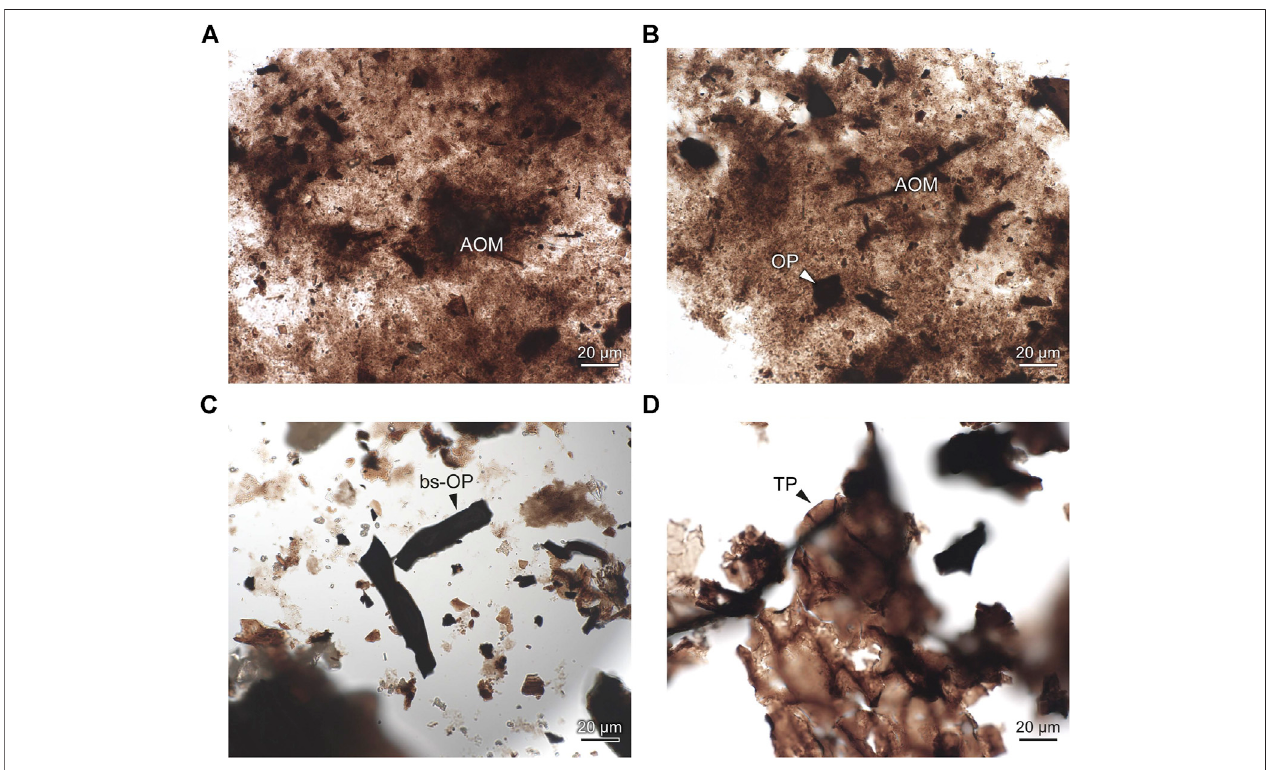
FIGURE7| PalynofaciesmicrophotographsfromtheCHE-1core. (A) amorphousorganicmatter(AOM – probablyalgal-bacterial-derived),245.6 m; (B) AOMand opaque phytoclasts (OP), 245.6 m; (C) details of blade-shaped opaque phytoclasts (bs-OP), 219.45 m; (D) details of translucent phytoclast (TP), 210.6 m.